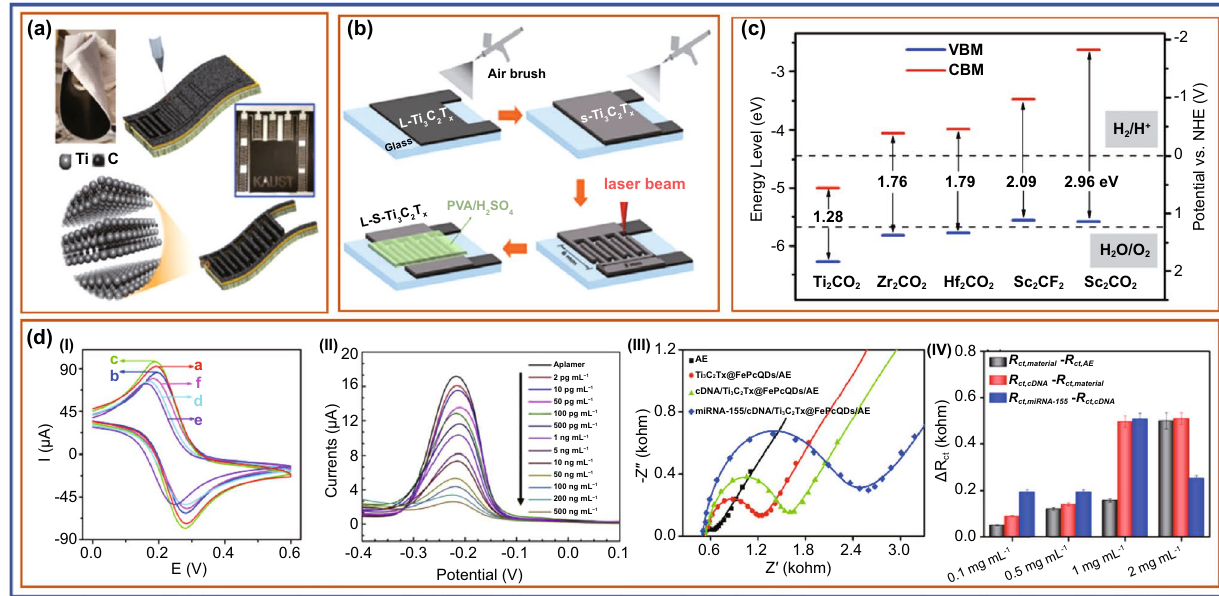
Fig. 9 a Representation of the laser patterning of paper coated with MXene to form an interdigitated electrode for MSCs devices. Copyright from Ref. [213]. b Schematic illustrating the fabrication process of the all-Ti 3 C 2 Tx MXene MSC. Copyright from Ref. [215]. c The electronic band-gap for various MXenes sheets. Copyright from Ref. [214]. d (I) CV curves of different modified electrodes. Copyright from Ref. [166], (II) DPV responses to different concentrations (2 to 500 pg mL −1 ) of CEA antigens. Copyright from Ref. [216], (III) EIS Nyquist plots of the miRNA-155 detection in 5.0 mM [Fe(CN) 6 ] 3−/4− containing 0.01 M PBS. Copyright from Ref. [167]. (IV) The corresponding variations of the −1 ) for detecting miRNA-155 detection procedures ( n = 3). Copyright from R ct values with different concentrations (0.1, 0.5, 1, and 2 mgmL